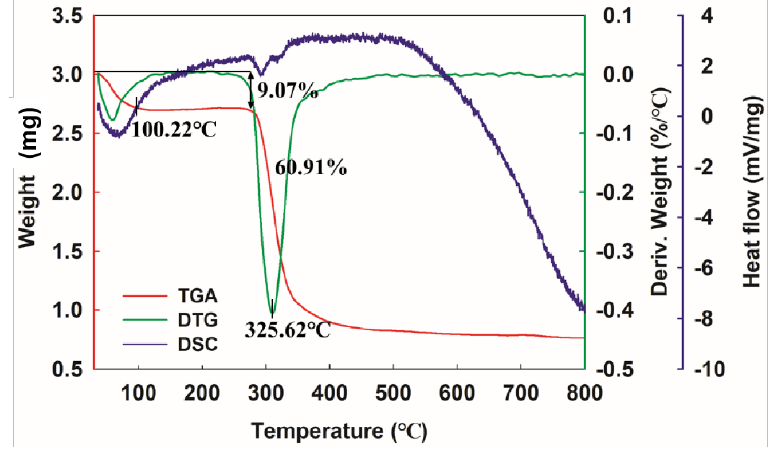
Figure 5. The thermal properties of dextran. Red curve is TGA, green curve is DTG, purple curve is DSC.